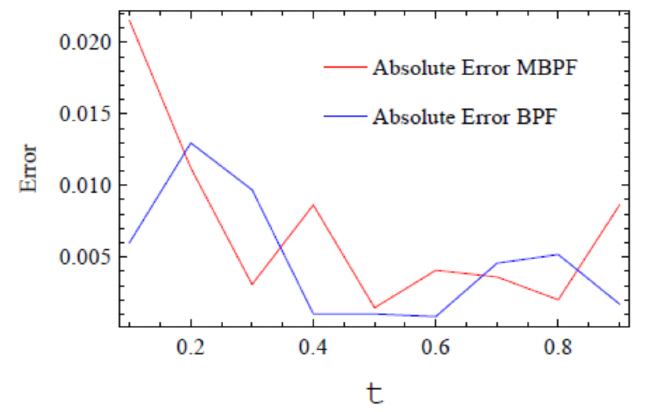
Figure 8. The absolute error of IBPFs and BPFs expansions comparison at random points.